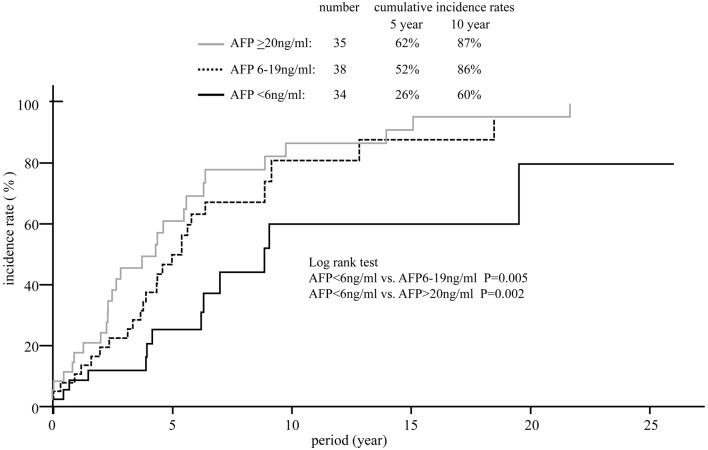
Cumulative incidence rates of hepatocellular carcinoma (HCC) according to α-fetoprotein (AFP) levels.